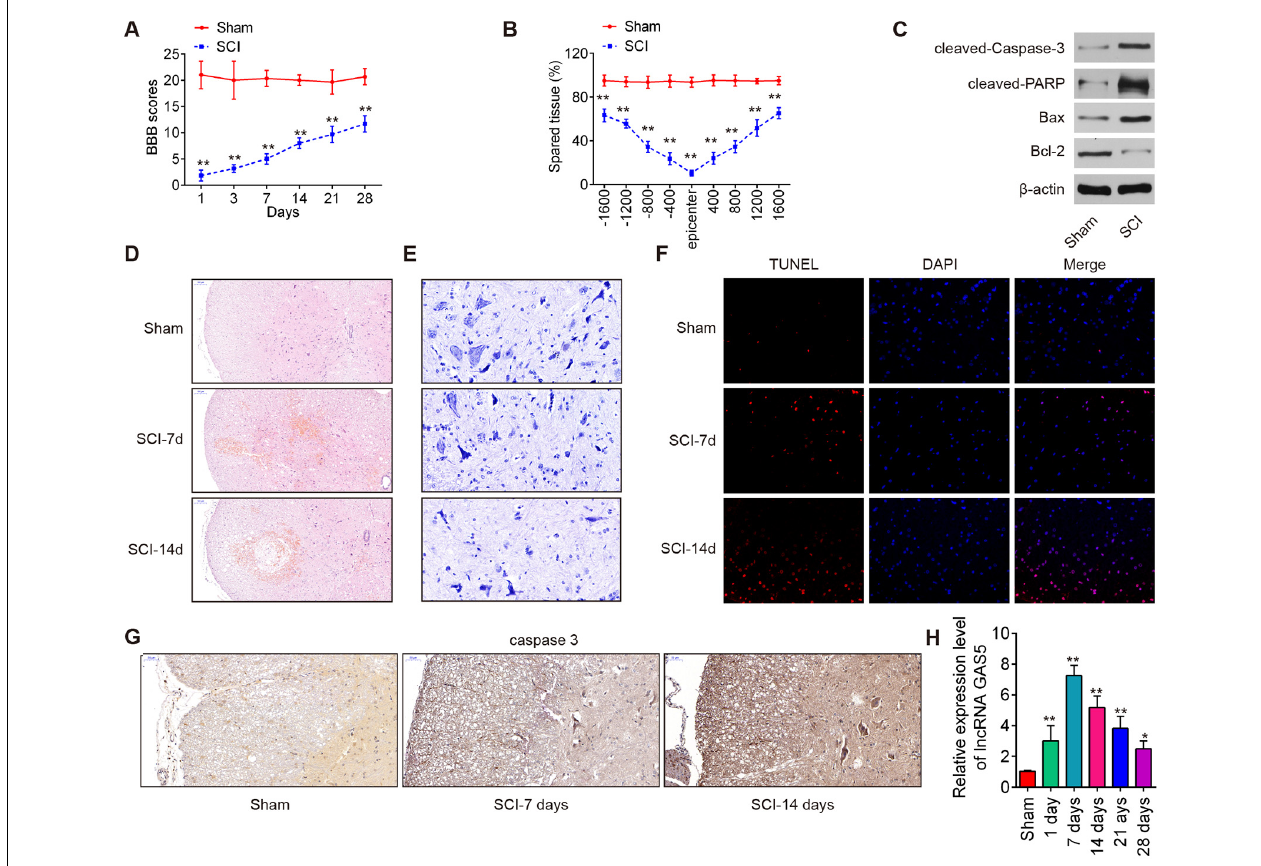
FIGURE 1 | Long noncoding RNA (LncRNA) growth arrest–specific transcript 5 (GAS5) expression in spinal cord tissues of spinal cord injury (SCI) mice. (A) Basso, Beattie, and Bresnahan (BBB) scores for hindlimb locomotion in the SCI group and the sham group ( n = 10 per group). (B) Lesion analysis at the rostral ( − ) and caudal (+) margins from the lesion epicenter as indicated using cresyl violet staining 14 days after the SCI model was established ( n = 10 per group). (C) Protein expressions of Bcl-2, Bax, cleaved caspase-3, and cleaved PARP in spinal cord tissues measured using Western blot ( n = 10 per group). (D) Representative pictures of H&E staining of the ventral horn of the mice spinal cord. The scale bar is 50 µ m. (E) Representative images of Nissl staining of the spinal cord (magnification 400 × ). (F) Apoptosis in spinal cord tissues determined by terminal deoxynucleotidyl transferase dUTP nick end labeling (TUNEL) assay. (G) Immunohistochemistry (IHC) analysis of cleaved caspase-3 7 and 14 days after SCI. (H) Relative expression levels of long noncoding RNA (lncRNA) GAS5 in spinal cord tissues in the mice SCI model group and the sham group ( n = 10 per group) using quantitative reverse transcription polymerase chain reaction (qRT-PCR). Notes: data represent the mean ± SD of three independent experiments. * p < 0.05, ** p < 0.01 vs. sham